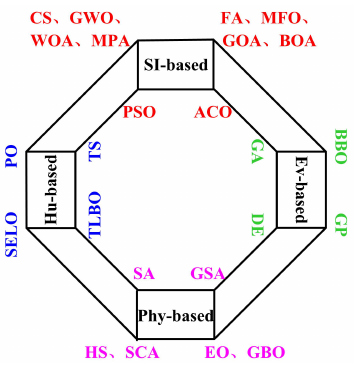
Figure 1. Classification of heuristic optimization